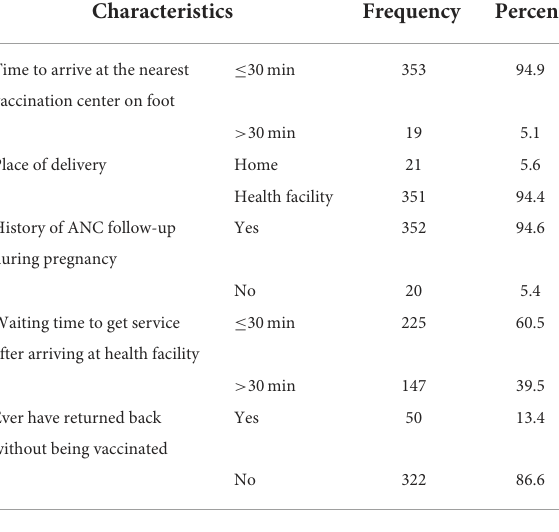
TABLE 2 Distribution of accesses and service-related factors among study participants for MCV2 vaccination and associated factors in urban areas of North Shoa Zone, Oromia Region, 2022.